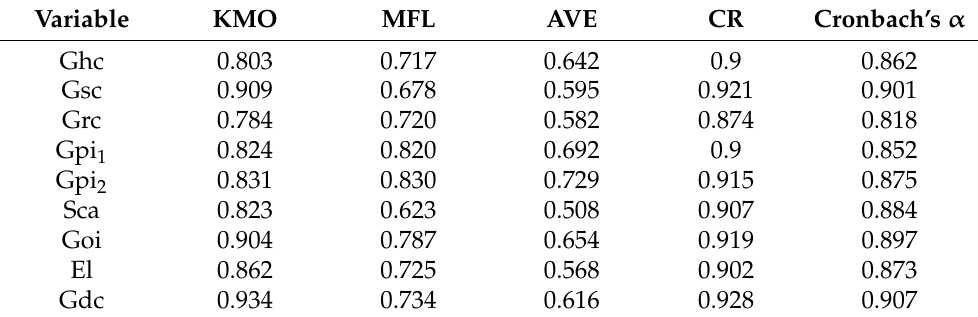
Table 2. Convergent validity and